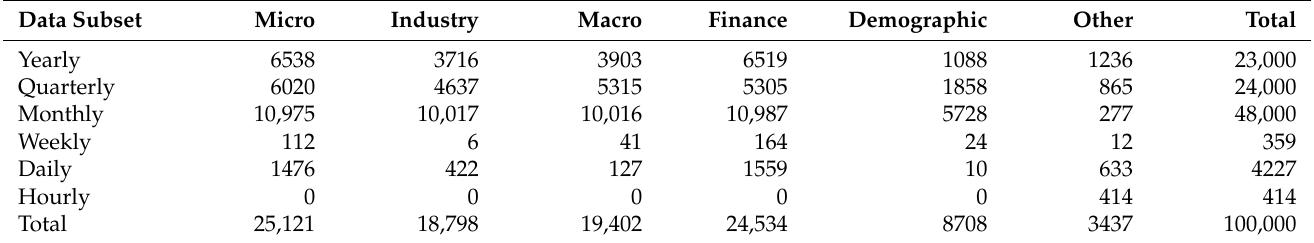
Table 1. Number of series per data frequency and domain